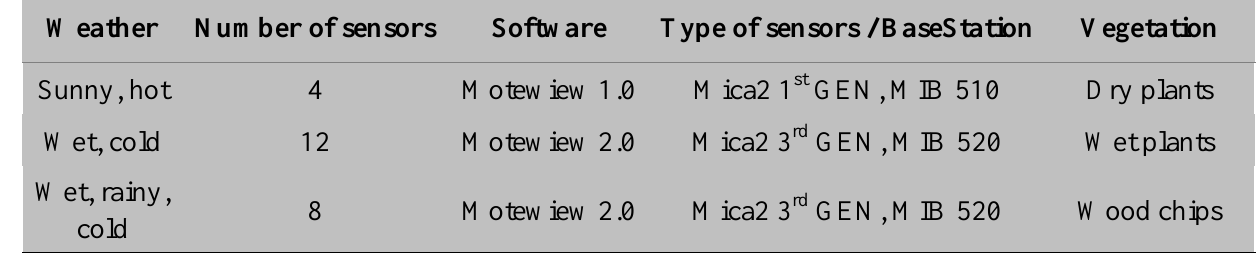
Table 2. Weather conditions and equipment